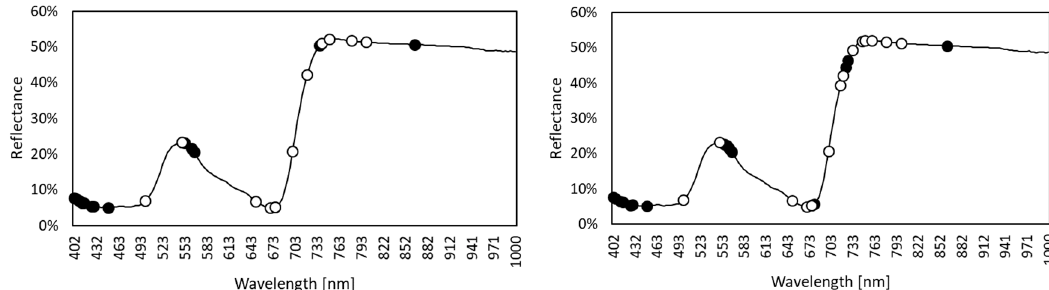
Figure 8. Spectral bands covered in the classification algorithms, as selected by the NCA algorithm for the models before ( left graph ) and after the outlier elimination ( right graph ). White dots depict the bands that came of the VI formulas and black dots the bands that were selected as